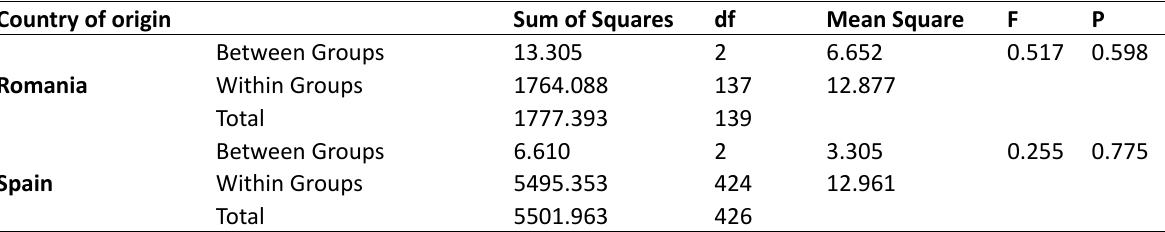
Table 6. Results of the analysis of variance on adherence to the MD and PA, for students from Romania and Spain